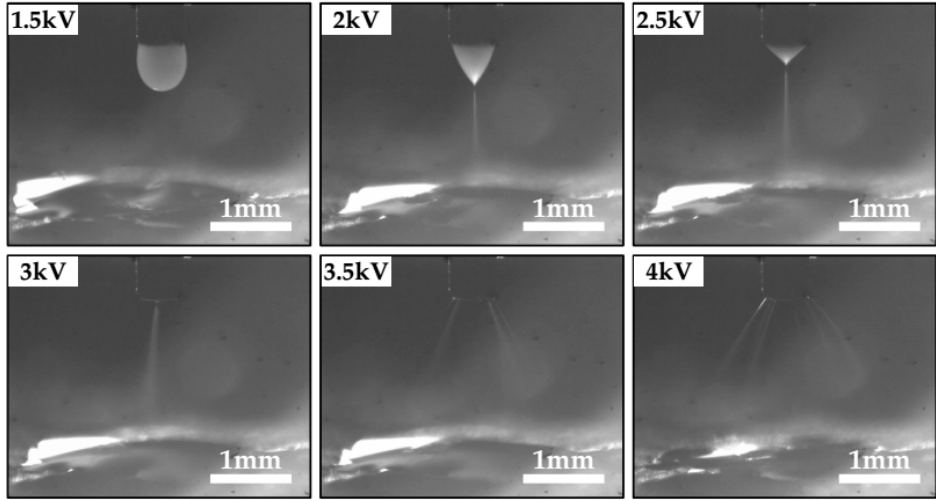
Figure 3. Photographs of the spray jet in near-field electrospray with varying applied voltages (solution concentration 10 wt %, flow rate 100 μ L/h, electrode gap 2 mm).